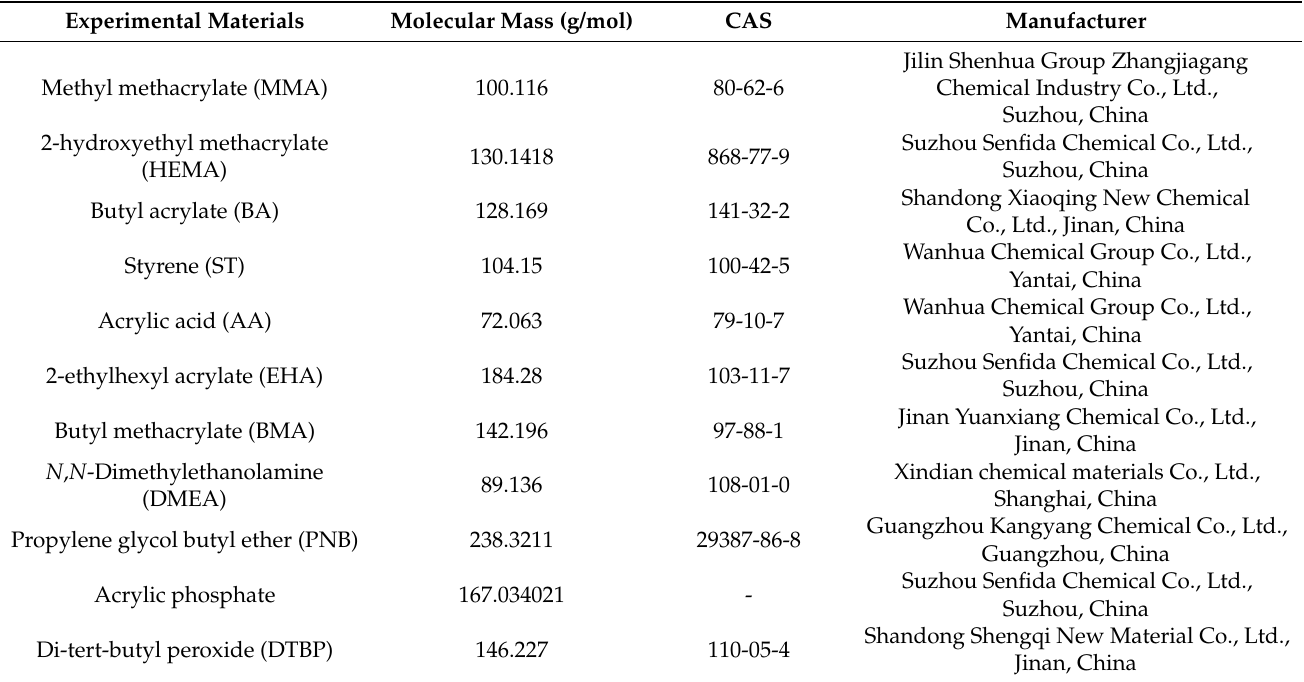
Table 1. List of experimental